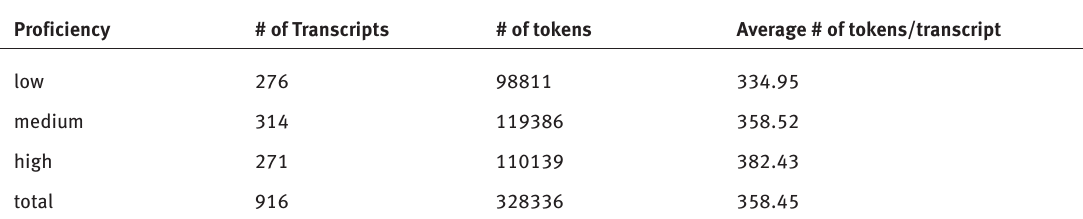
Table 2: Composition of the selected data from the SWECCL spoken